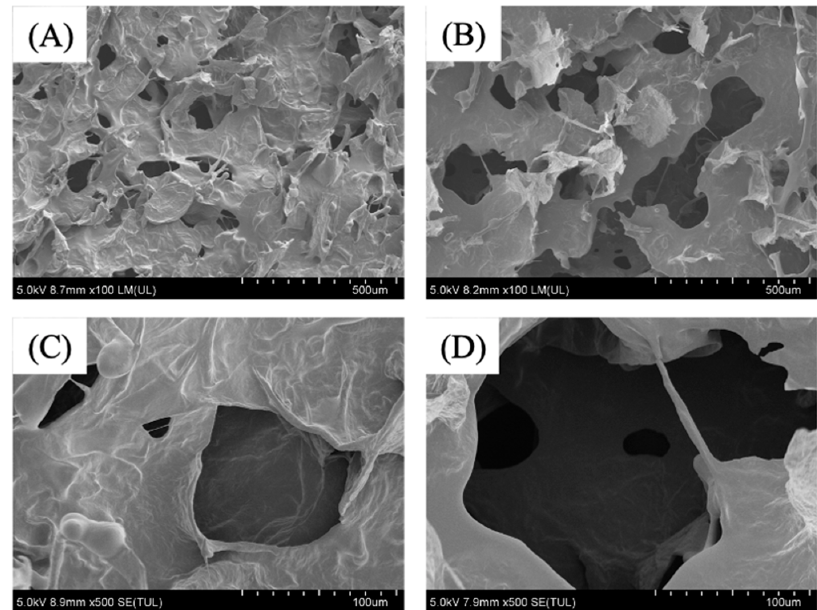
Figure 2. Microstructure of blended cubes. ( A ) VFD sample under 100× magnification (blended